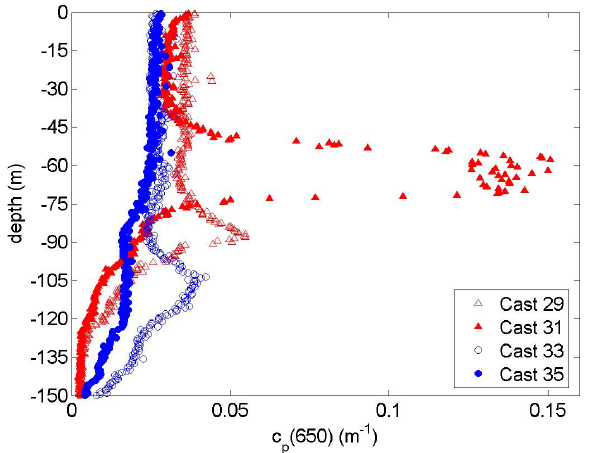
Fig. 6. Vertical profiles of attenuation coefficient for the four